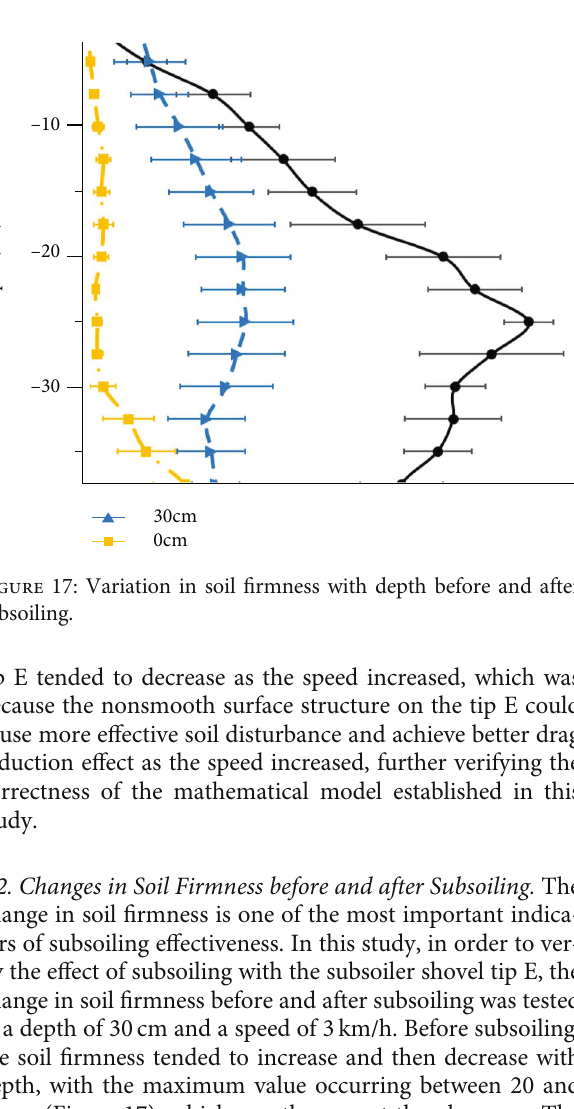
Figure 16: Mean values of subsoiling resistance for six types of subsoilers at three speeds and 40 cm depth.